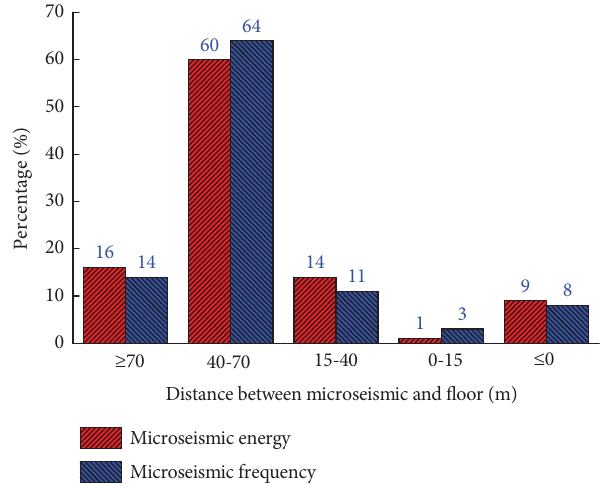
Figure 6: Distribution of microseismic energy and frequency in diferent layers.